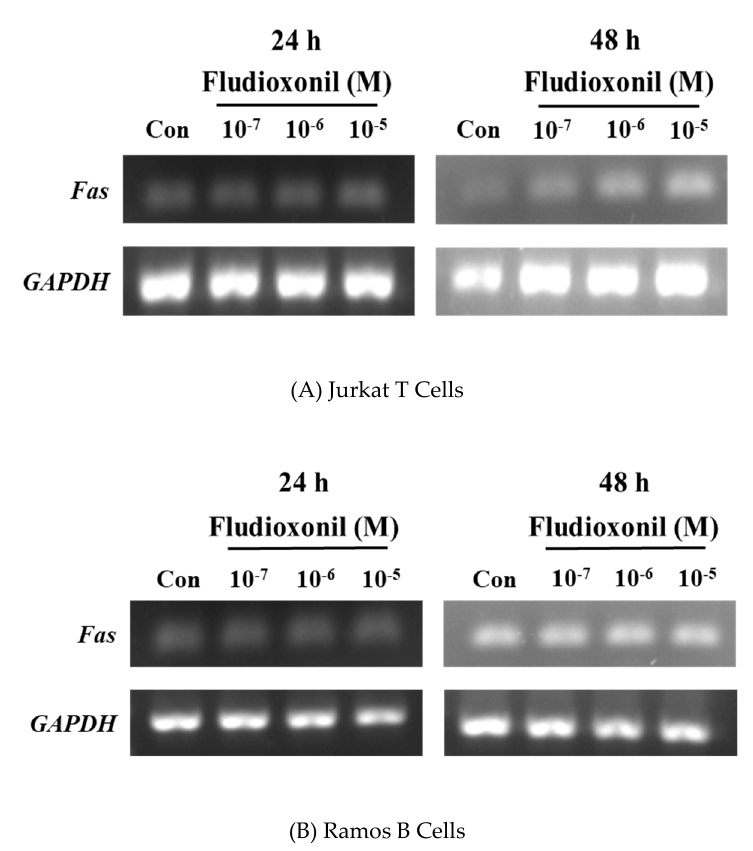
Figure 7. Expression of the Fas gene in Jurkat T cells and Ramos B cells. Jurkat T cells and Ramos B cells (100,000 cells / well) were seeded in 24-well plates, respectively, and treated by fludioxonil (10 − 7 –10 − 5 M) for 24 or 48 h. Total RNA was extracted by TRIzol Reagent in Jurkat T cells and Ramos B cells. Total RNA converts to cDNA. Then, Fas gene expression was confirmed by semi-quantitative RT-PCR. ( A ) In Jurkat T cells, fludioxonil (10 − 7 –10 − 5 M) treated for 24 or 48 h. ( B ) Ramos B cells were treated with fludioxonil (10 − 7 –10 − 5 M) for 24 or 48 h. Each panel is representative of three separate experiments.